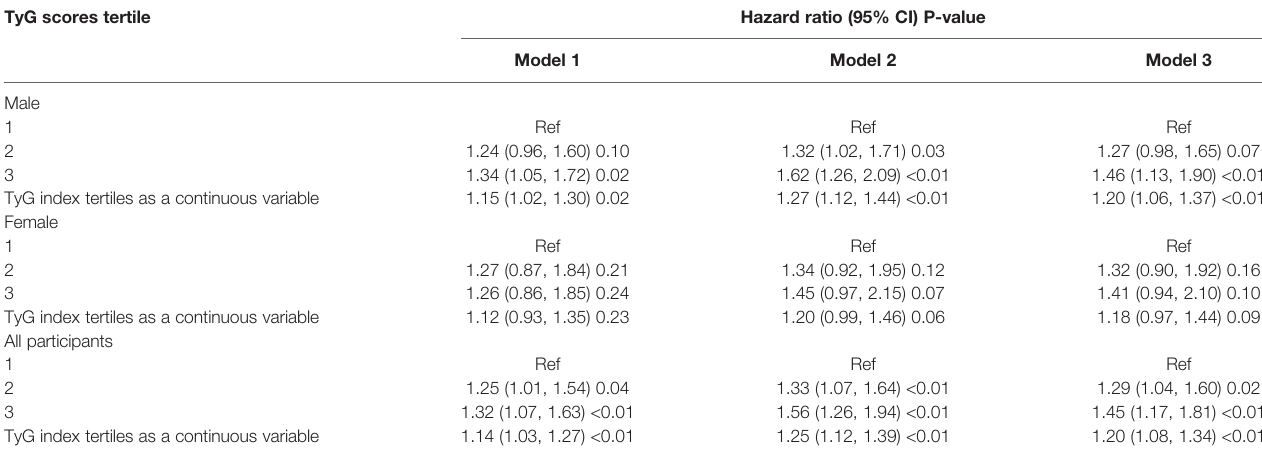
TABLE 2 | TyG index tertile and MACEs.